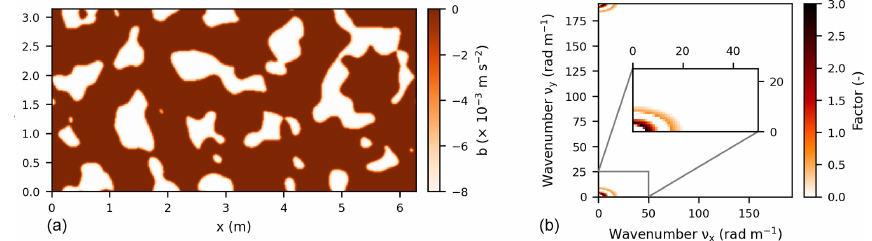
Figure B2. Generated surface temperature and the applied Fourier space in absolute form for the P30m simulation. The generated surface temperature (a) was obtained by applying the inverse fast Fourier transform in Fourier space (b) .